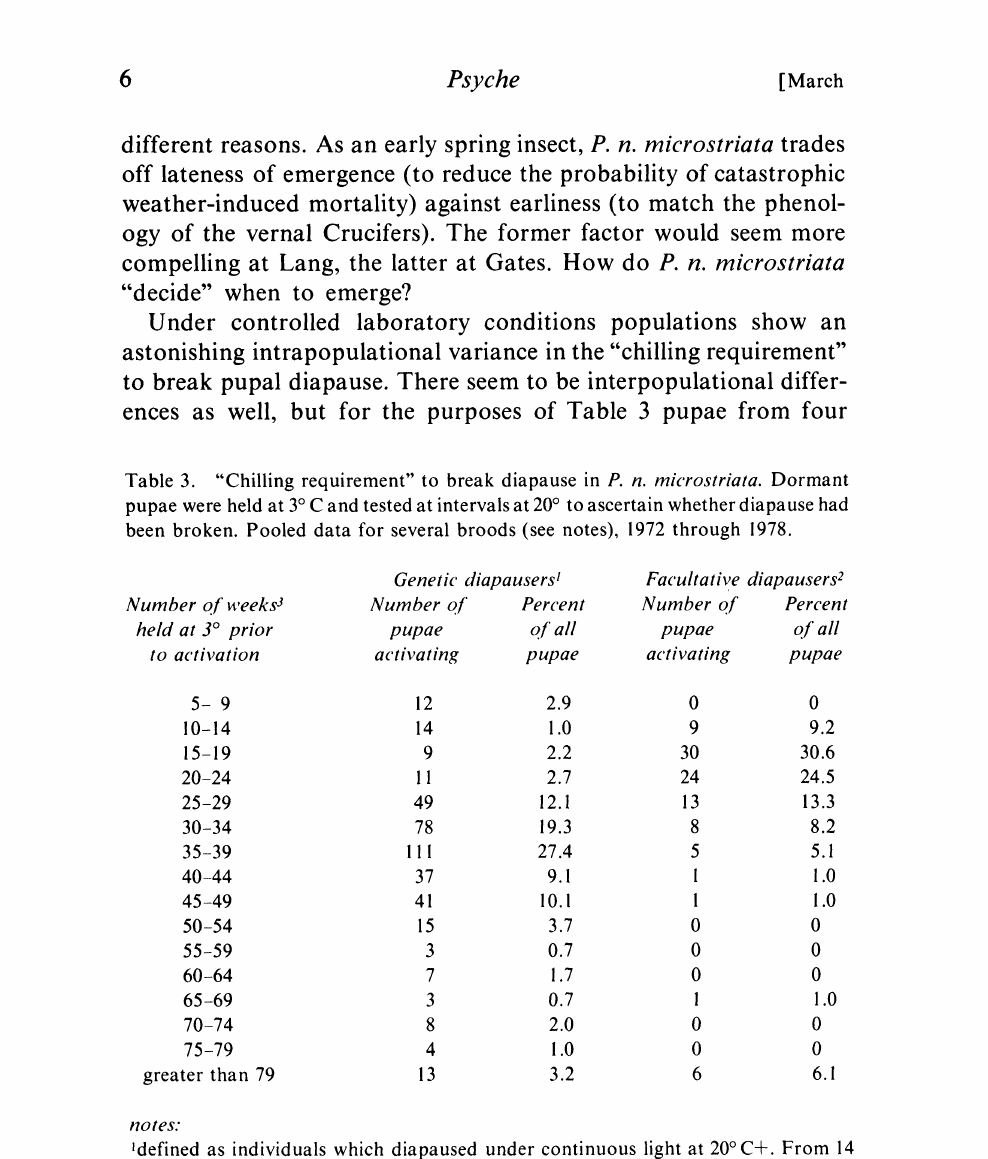
tlotes: defined as individuals which diapaused under continuous light at 20C+. From 14 females ex 3 foothill populations and mid-elevation Sierran